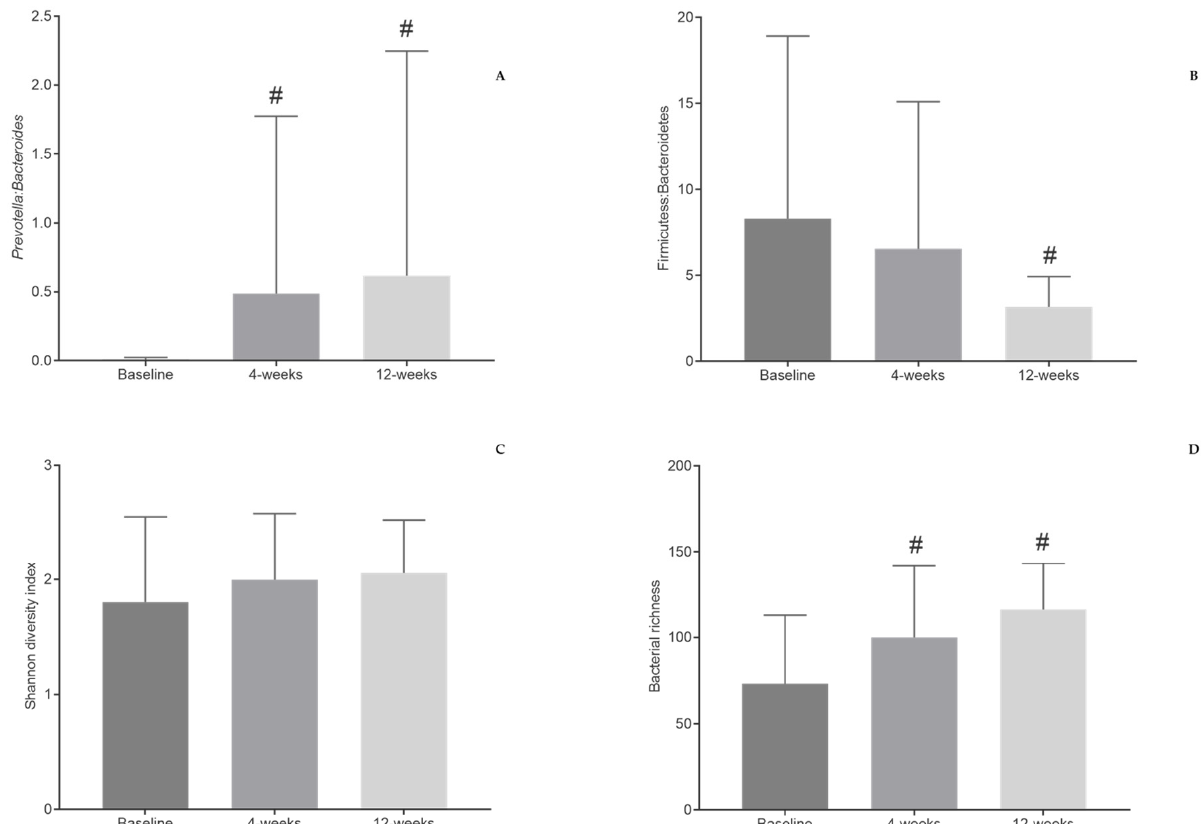
Figure 3. Changes in Prevotella to Bacteroides ratio ( A ), Firmicutes to Bacteroidetes ratio ( B ), bacterial diversity ( C ), and bacterial richness ( D ) after 4 weeks and 12 weeks of the intervention. # Differences were considered clinically relevant when |d| > 0.50 vs.